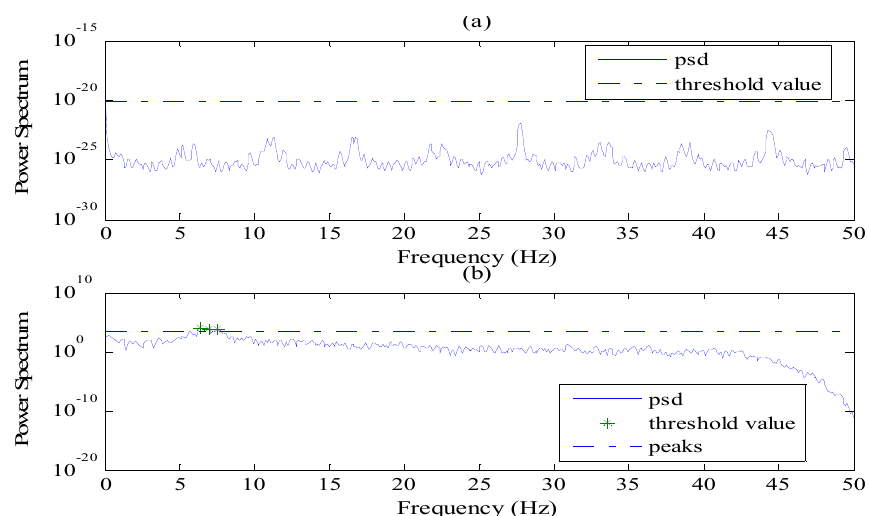
Figure 1. Examples of power spectra that cannot show accurate information about a cable’s frequency. ( a ) A cable vibration that is too weak to exhibit the obvious peaks; ( b ) A power spectral density (PSD) with many false peaks found through the regular peak-picking method.